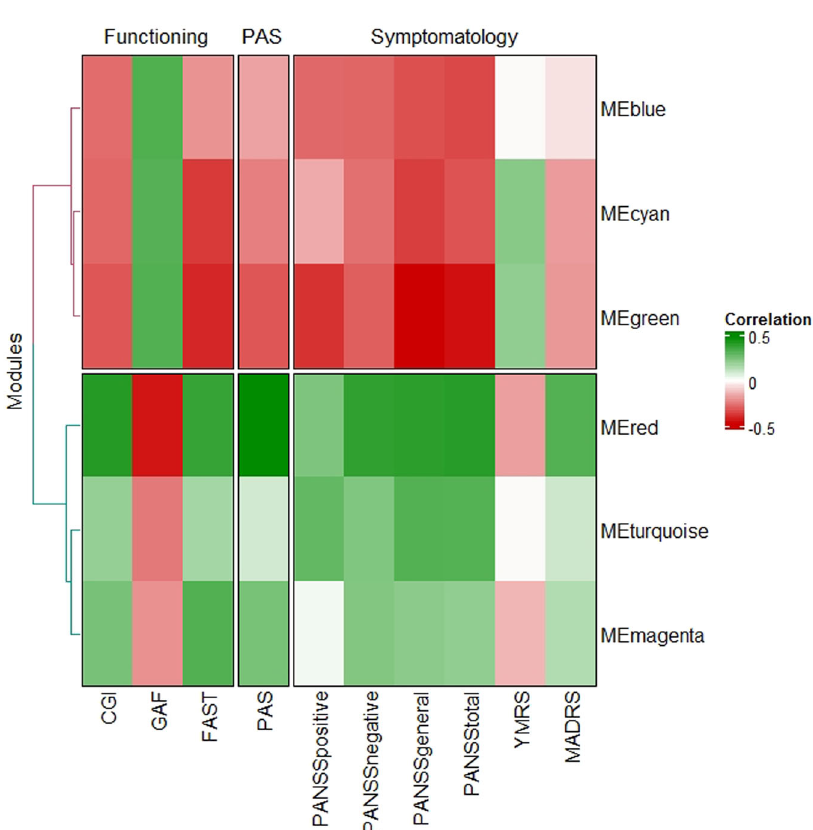
Fig. 1 Heatmap of the Pearson correlation coef fi cient between module eigengenes (MEs) and clinical information. The color of the cell re fl ects the size of the correlation coef fi cient, as shown in the legend on the